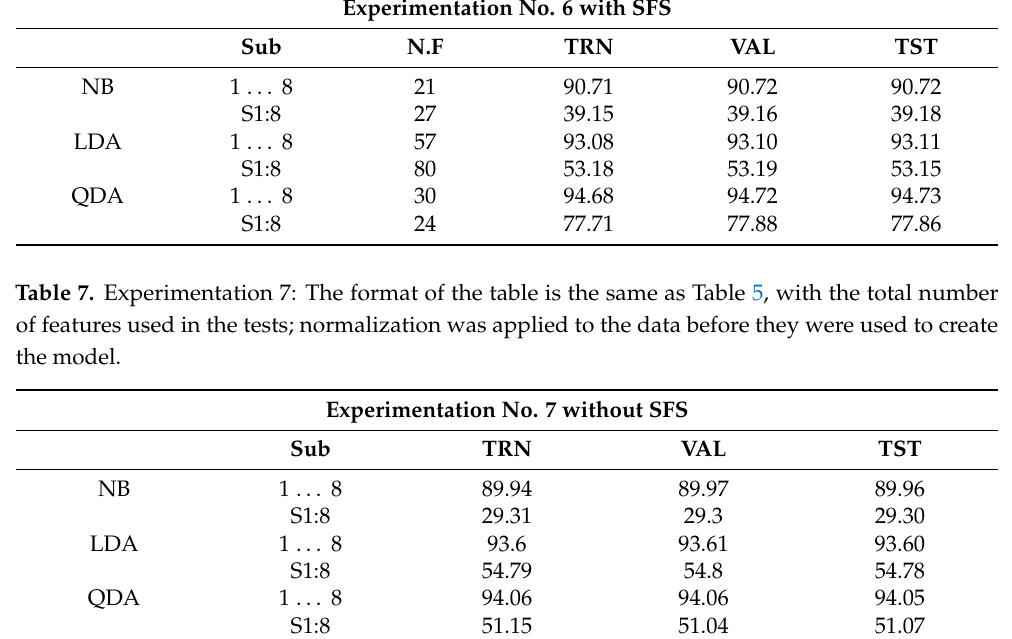
Table 6. Experimentation 6: Percentage of recognition using a 10 × 10 cross-validation by dividing the data into training (TRN), validation (VAL) and test (TST). The subject column is divided into two parts for each classifier; 1 . . . 8 indicates that an average was performed between the data of the eight subjects; S1:8 indicates that the total data were a single set of the eight individuals. The N.F column is the number of features selected through SFS.